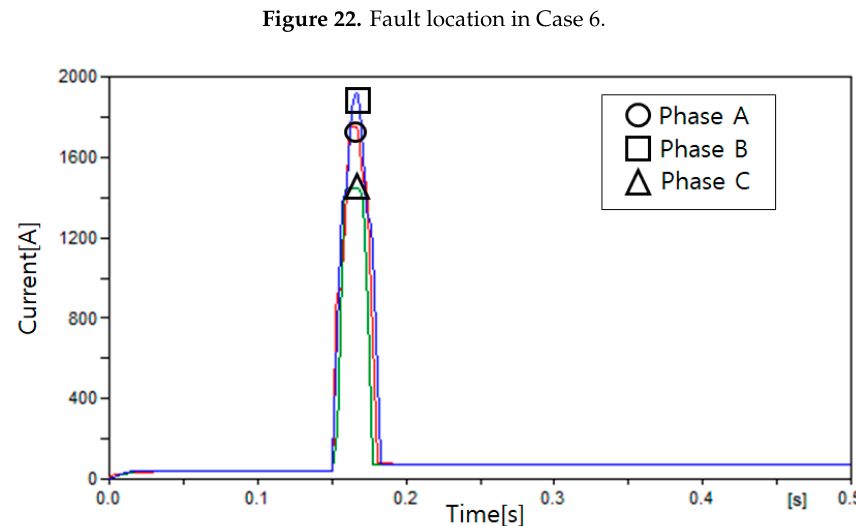
Figure 23. Current measured at I 2 in Case 6.